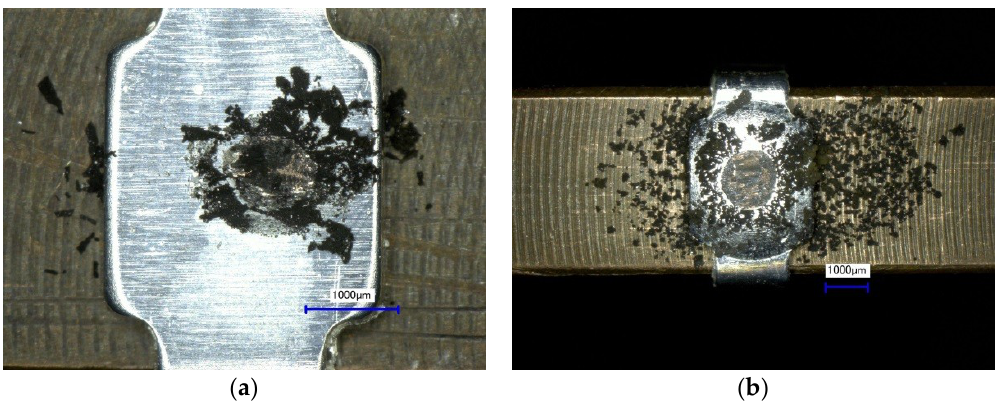
Figure 8. Distribution of the wear debris of different sample arrangement: ( a ) on the plane part after 6.2 × 10 4 fretting cycles, arrangement “sphere on plane”; ( b ) on the sphere part after 1.3 × 10 5 fretting cycles, arrangement “plane on sphere”.